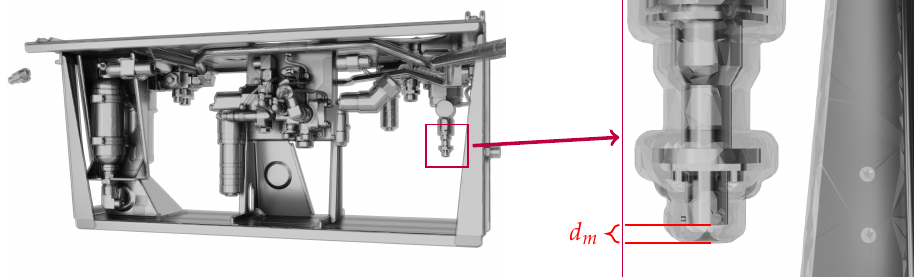
Figure 6. Airbus A320 mounting rack geometry with margin in all spatial directions.